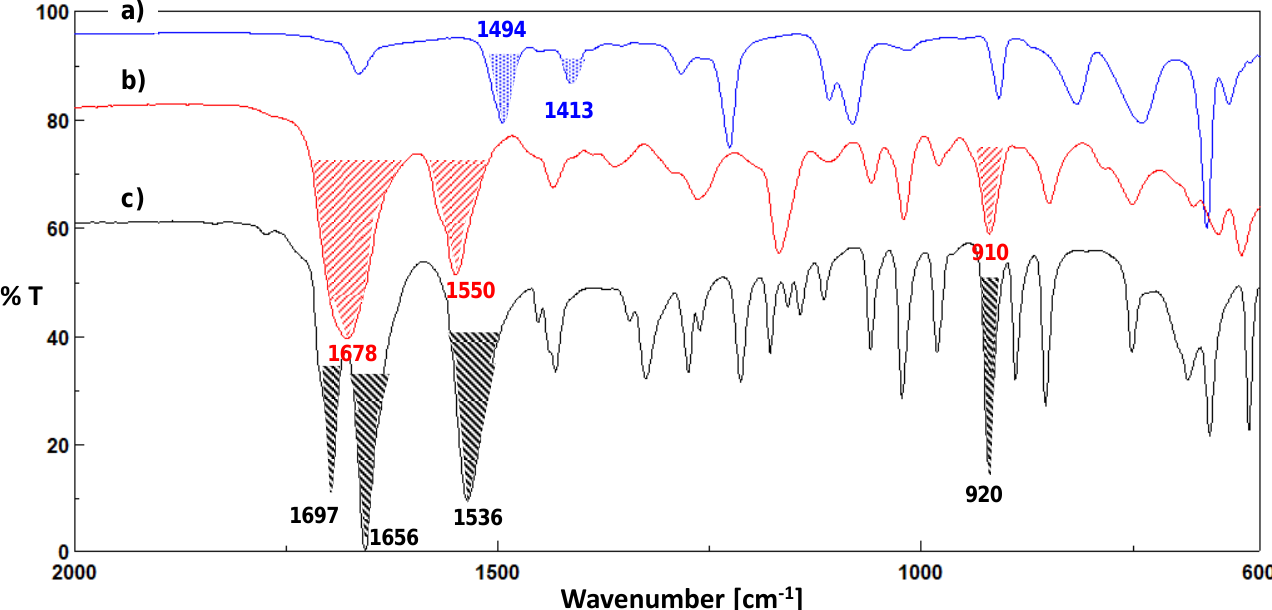
Figure 2. Synthesis of the polymer 6 monitored by ATR-FTIR. ( a ) Polymer 5 , ( b ) Polymer TS-PIL 6 and ( c ) alkylating agent containing amino-thiolactone units ( 3 ).